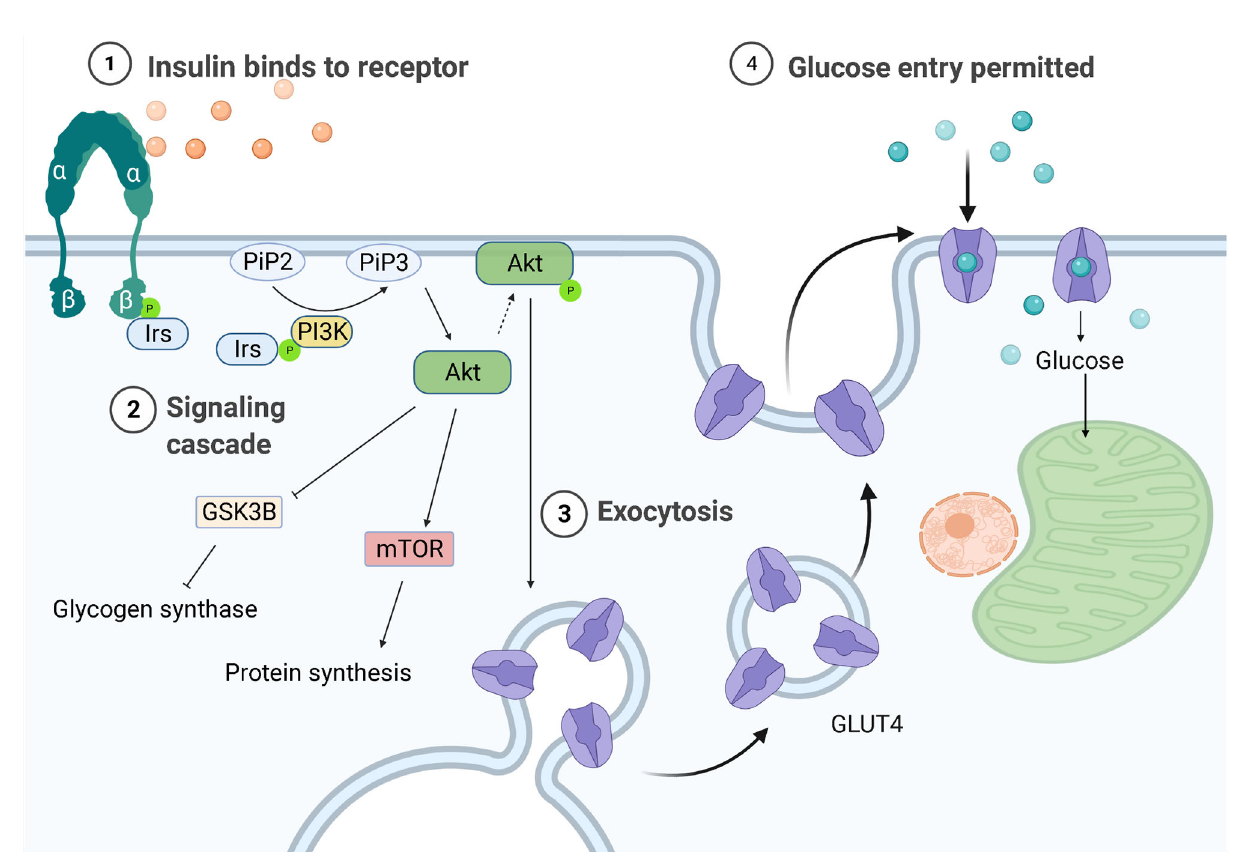
FIGURE 1 | Regulation of glucose entrance through insulin signaling. Insulin receptors are tyrosine kinases consisting of two extracellular a -subunits and two transcellular b -subunits. In healthy individuals, insulin will bind the a subunit of the insulin receptor, causing a conformational change that leads to phosphorylation of tyrosine residues in its b subunit. The proteins insulin receptor substrates 1 or 2 (Irs-1/-2) will then bind to the tyrosine-phosphorylated region of insulin receptors and be themselves phosphorylated. Phosphoinositide-3-kinase (PI3K) will bind to the phosphorylated IRS-1 or -2 and be activated, producing 3-phosphorylated polyphosphoinositides (PiP3) from phosphatidylinositol 4,5-bisphosphate (PiP2). PiP3 will recruit the serine/threonine kinase Akt (also known as protein kinase B) from the cytosol to the plasma membrane, where it will be phosphorylated and activated, leading to glycogen synthase kinase-3 b (GSK3B) inhibition and therefore to higher glycogen synthesis. AKT is also responsible for the translocation of the glucose transporter (GLUT4) to the plasma membrane, allowing glucose